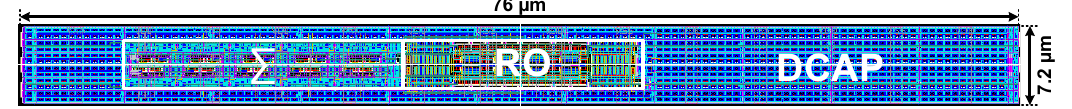
Figure 15. TDC layout.